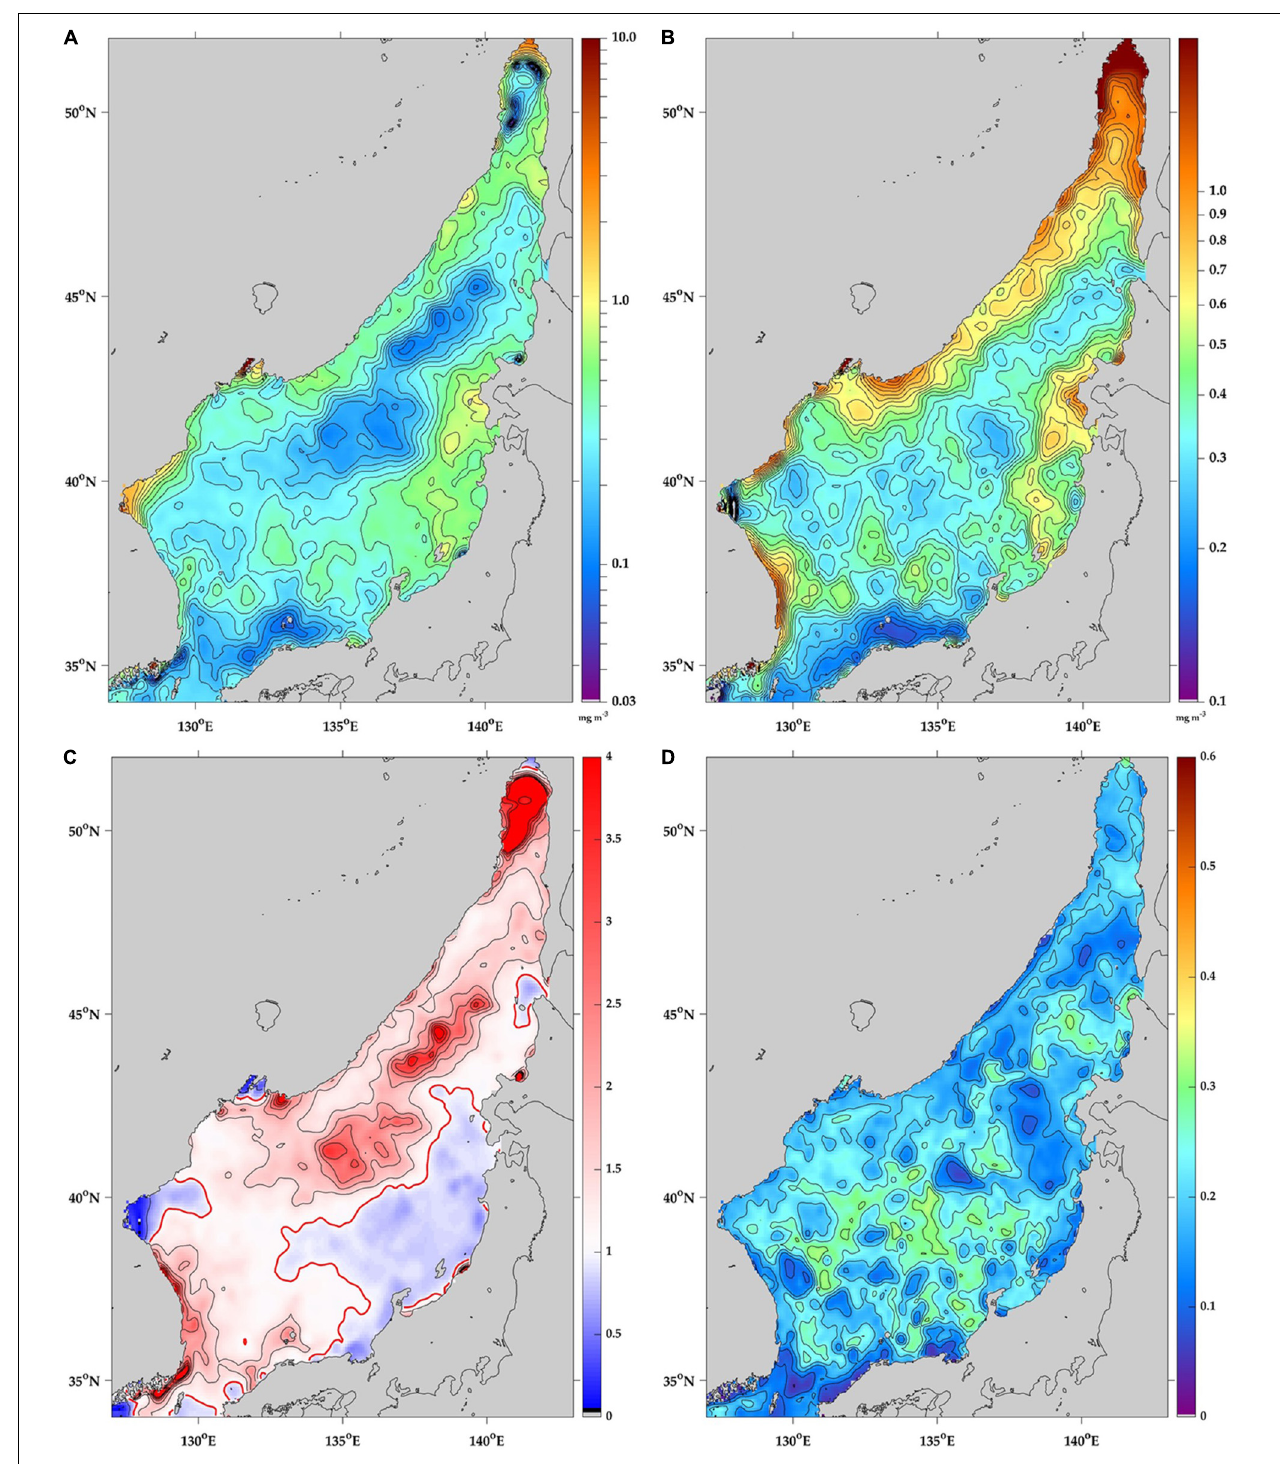
FIGURE 5 | Spatial distribution of the amplitudes of the (A) annual cycle, (B) semi-annual cycle, (C) ratios of semi-annual to annual cycles, where the red contour corresponds to a ratio of 1.0, and (D) the ratios of the amplitudes (1–4 cycles per year) of seasonal variations to the total temporal variance of chlorophyll- a concentrations in the East Sea (Sea of Japan) for the period of